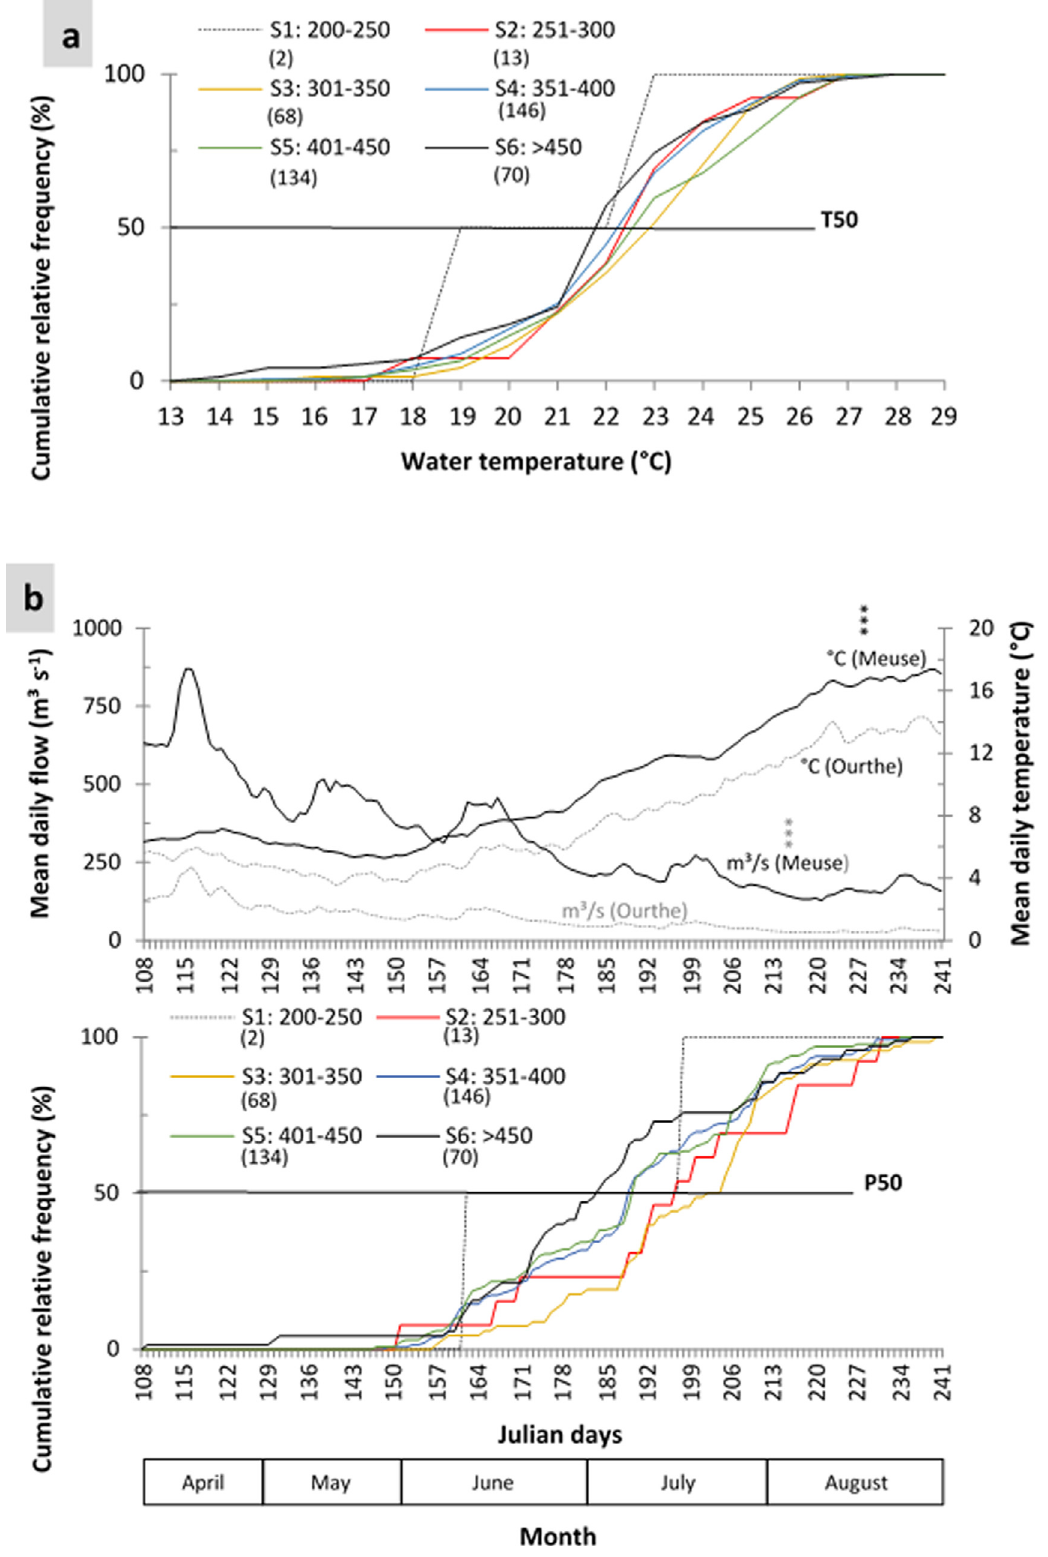
Fig. 5. Water temperature at detection (a) and detection period (b) relative to the mean daily temperature and fl ow of the Meuse River and the Ourthe tributary during the study period from 2010 to 2015. Numbers in brackets indicate the sample size of the size classes ( S 1 (cid:3) S 6 , in mm) of eels for temperature and period. T50 and P50 indicate medians for temperature and period,